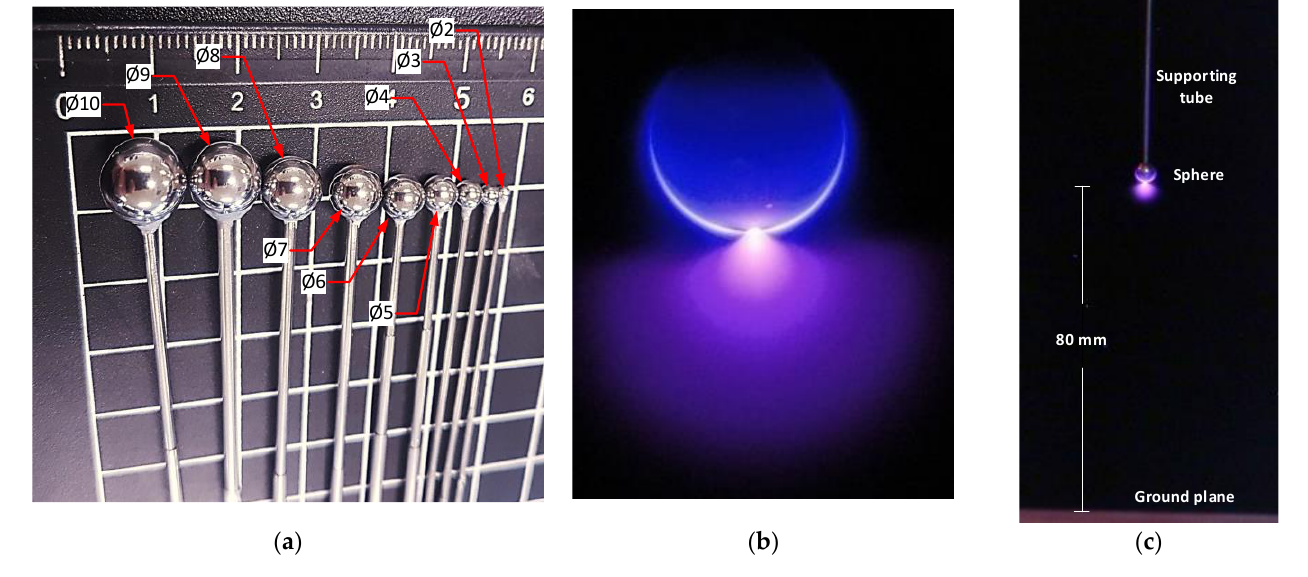
Figure 4. Sphere electrodes. ( a ) Photograph of the sphere electrodes used in the experiments. With the respective diameters. ( b ) Corona image taken with the CMOS imaging sensor to validate the location of the corona discharges before CEV acquisition. ( c ) Photograph of the sphere-to-plane electrode setup under an electrical discharge.